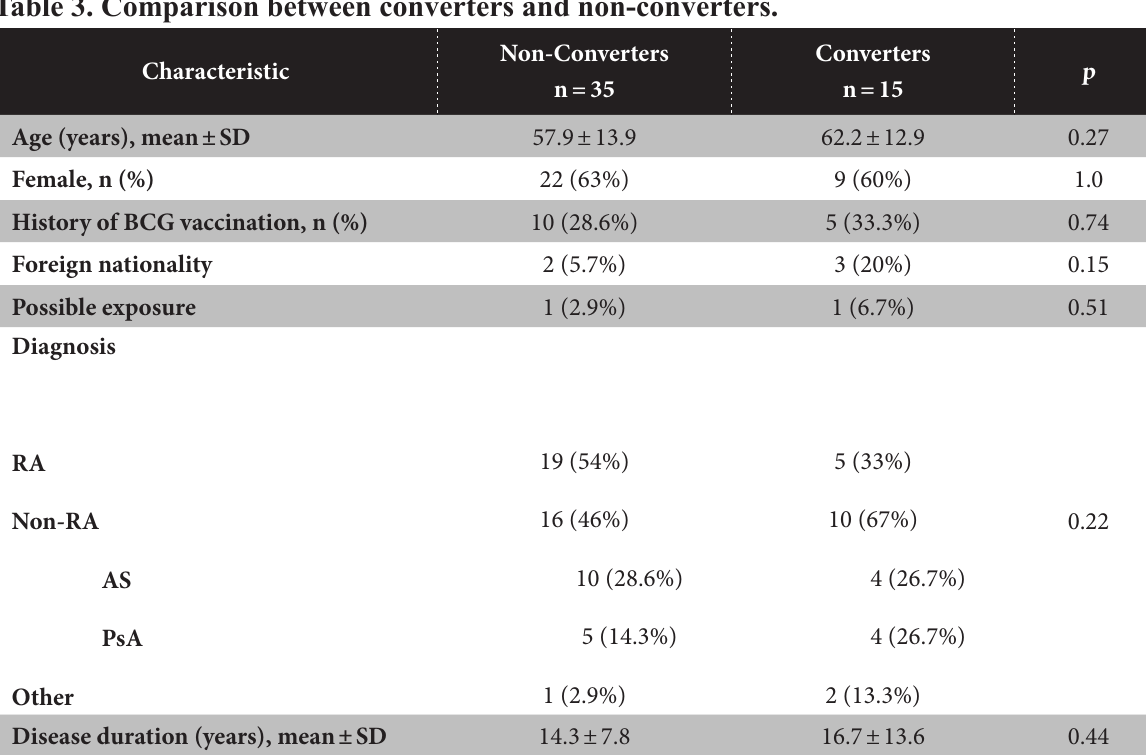
Table 3. Comparison between converters and